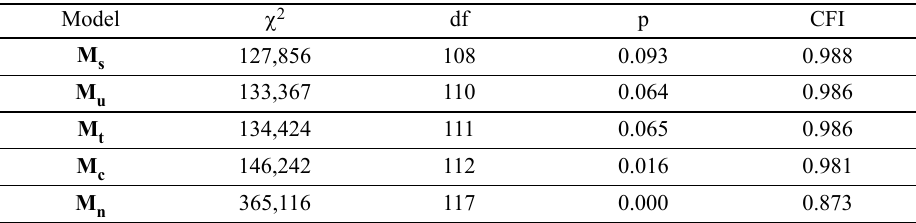
Table 4. Nested models